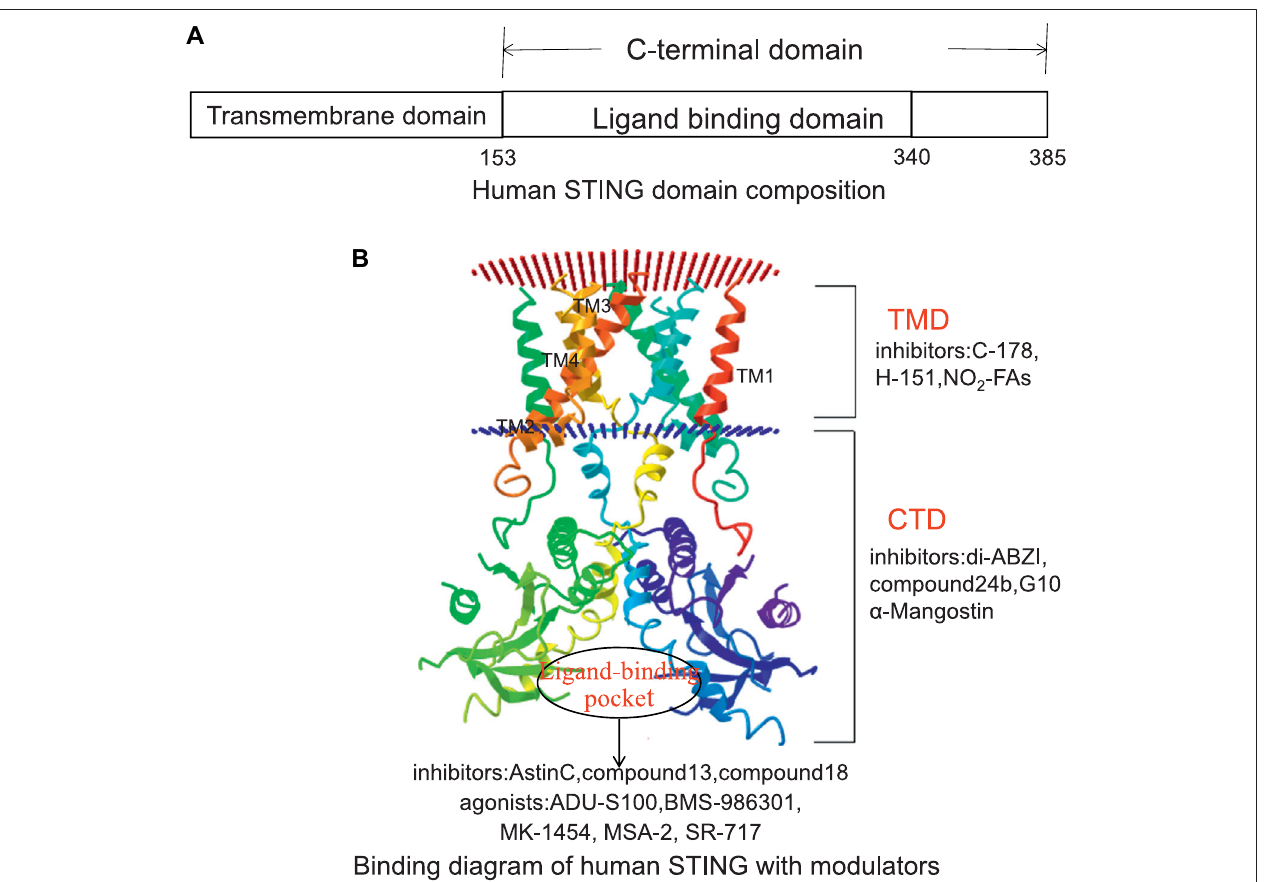
FIGURE 3 | The potential targeting sites of STING modulators, as shown on the Cryo-EM structure of human STING (Adopted from PDB ID: 6NT5). (A) Human STING domain composition. Human STING protein, as a homologous dimer, is composed of a luminal N-terminal domain (TMD, amino acid residues 1 – 152) and a cytoplasmic C-terminal domain (CTD, amino acid residues 153 – 385) containing ligand-binding domain (amino acid residues 153 – 340). (B) Binding diagram of human STING with modulators. The inhibitors targeting the TMD domain include C-178, H-151, and NO 2 -FAs. The inhibitors targeting the CTD domain include di-ABZI, Compound 24b, G10, and α -Mangostin. The inhibitors targeting the ligand-binding sites include astin C, Compound13, and Compound18. Its agonists include ADU-S100, BMS-986301, MK-1454, MSA-2, and SR-717.